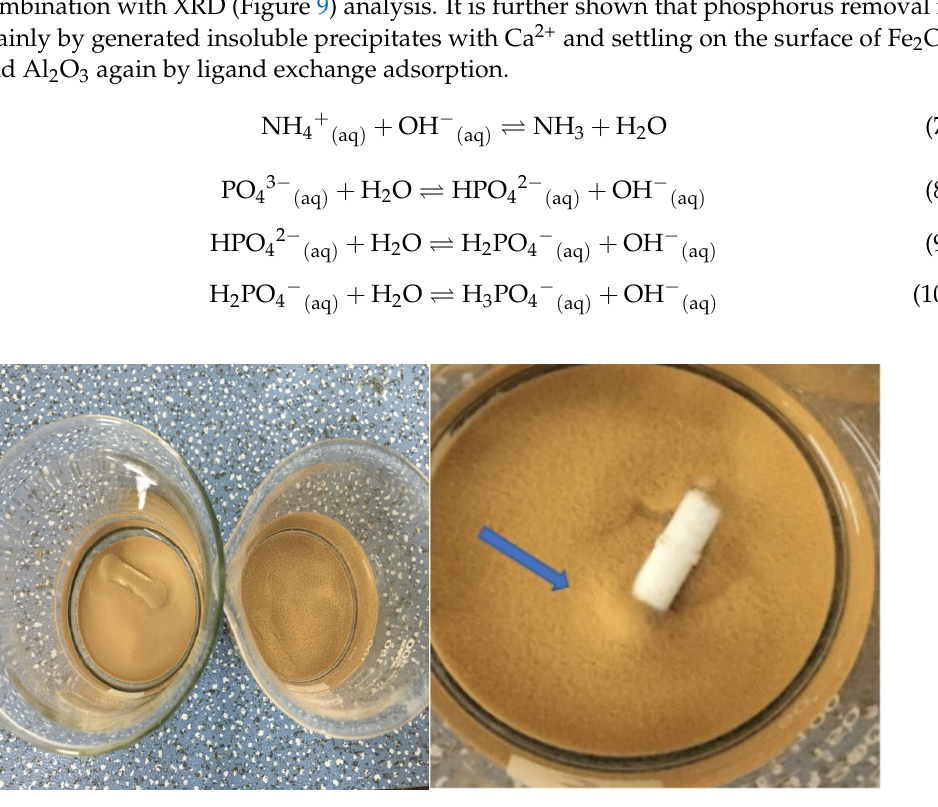
Figure 8. The image of the adsorbent forming flocculation after adsorption and precipitation.